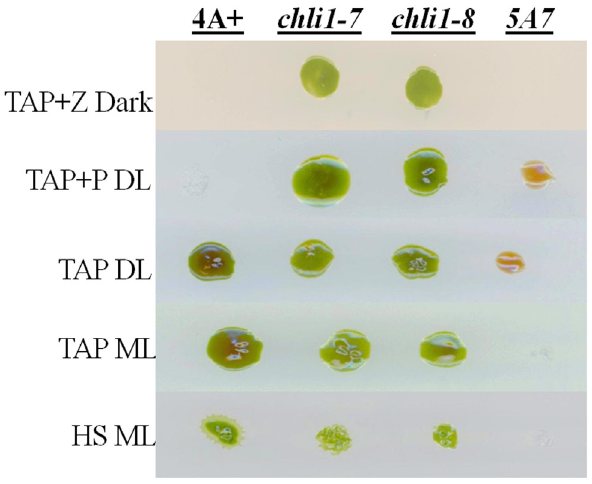
Figure 9. Growth phenotype analysis of chli1-1 rescued transformants. chli1-1 rescued transformants, chli1-7 and chli1-8 , were grown with 5A7/chli1-1 and 4A+ under five growth conditions: TAP+Z (zeocin) in the dark, TAP in dim light (DL) (15 μmol photons m -2 s -1 ), AP+P (paromomycin) in DL, TAP in medium light ML (300 μmol photons m -2 s -1 ) and HS in